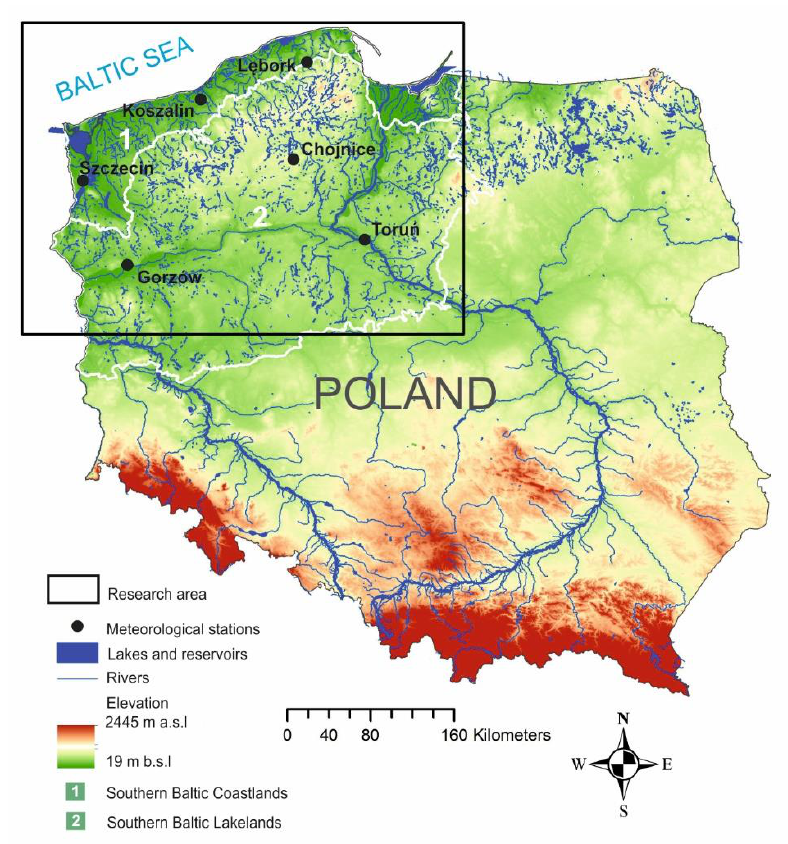
Figure 1. Research area shown in relief, with monitoring stations shown in relation to water network Table 1. Geographic position of weather stations